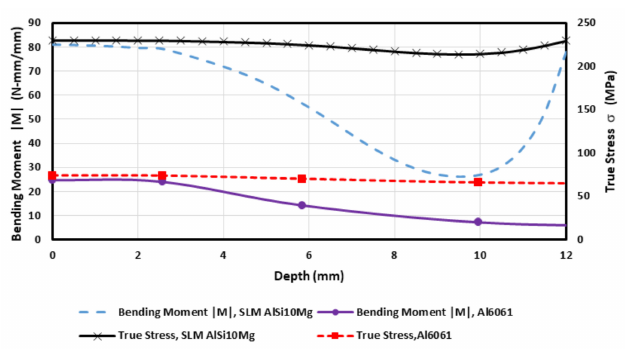
Figure 10. Calculated true stress and bending moment